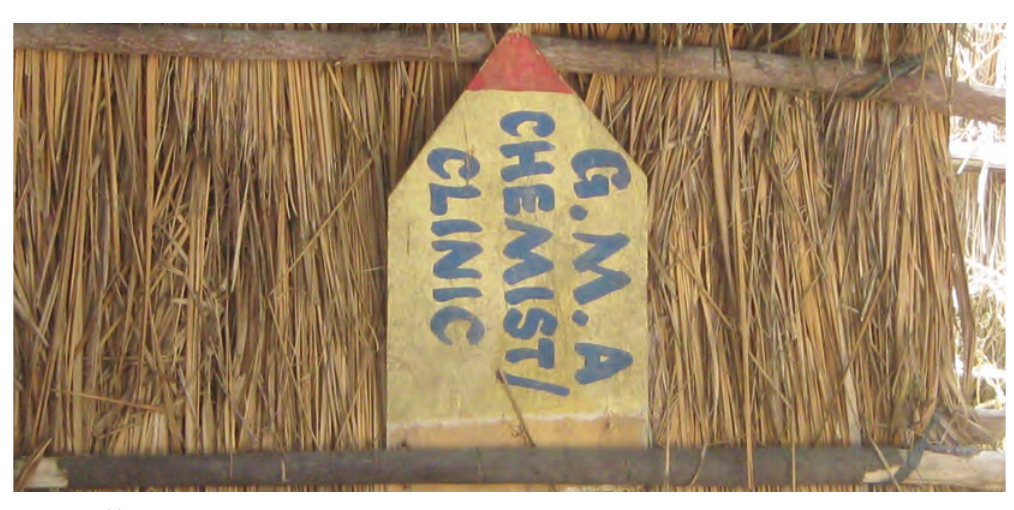
Figure 5. A local “Pharmacy Shop” at Faana